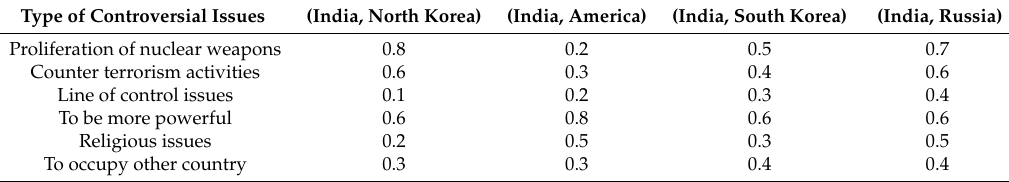
Table 5. Fuzzy set of controversial issues between India and other